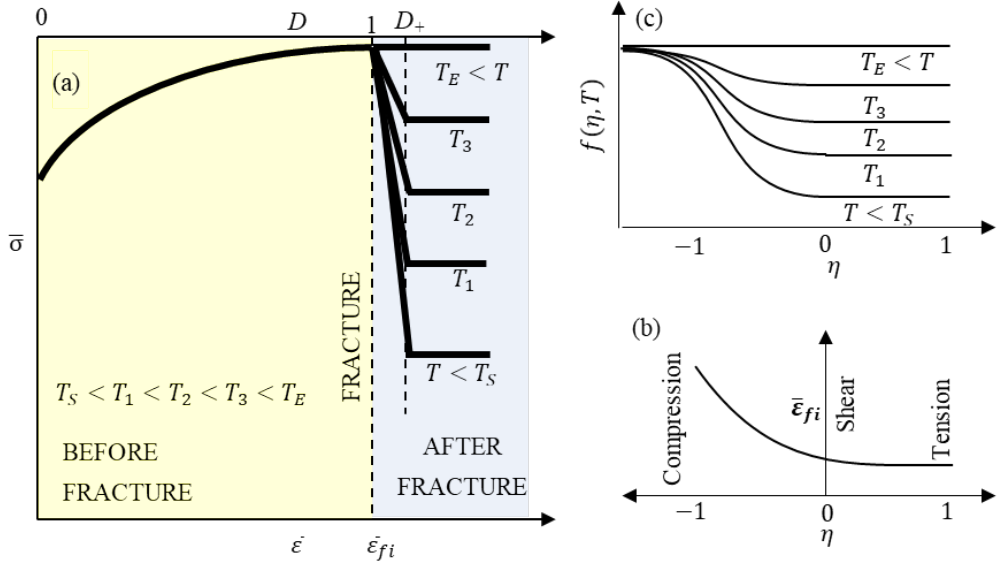
Figure 4. Experimental flow stress at 0.52 × 104 s −1 from El Magd et al. [6] fitted using the MJC Model.